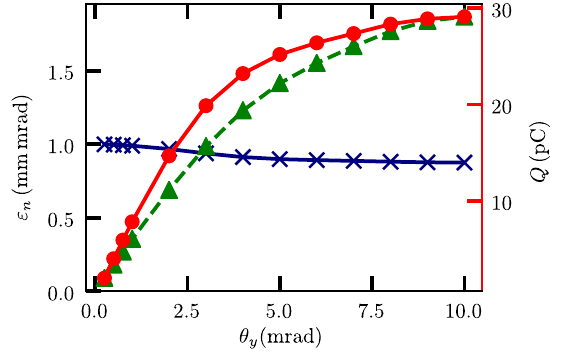
FIG. 10. Accelerated beam normalized phase emittance as a function of divergence angle in the y -direction, evaluated at the ¼ 0 . 35% . On the exit of the plasma target for the case with C N 2 left axis: normalized phase emittances, ε nx (blue crosses), and ε ny (green triangles) as a function of divergence in the y -direction θ y . On the right axis: beam charge (red circles) with respect to divergence in the y -direction θ y